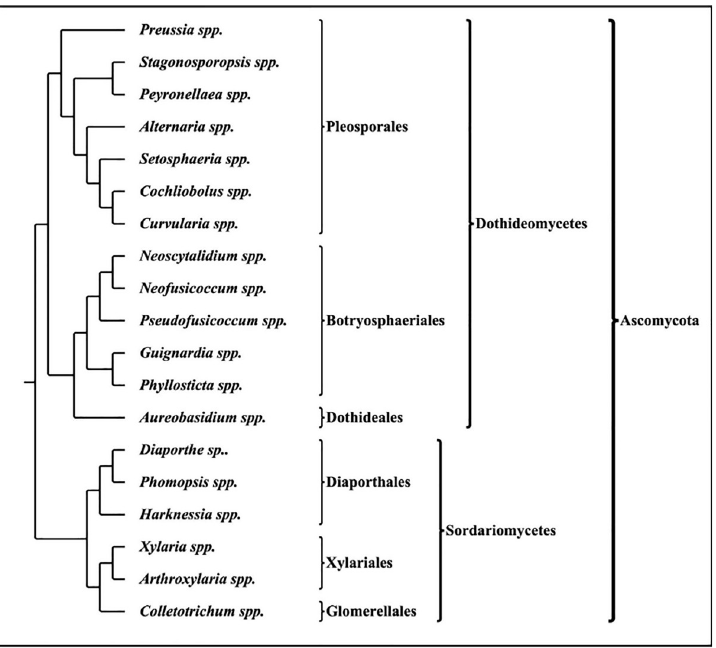
Fig 4. Taxonomical hierarchy of foliar endophytic fungi isolated from A . elaeagnoidea , F . inermis and P . serratifolia